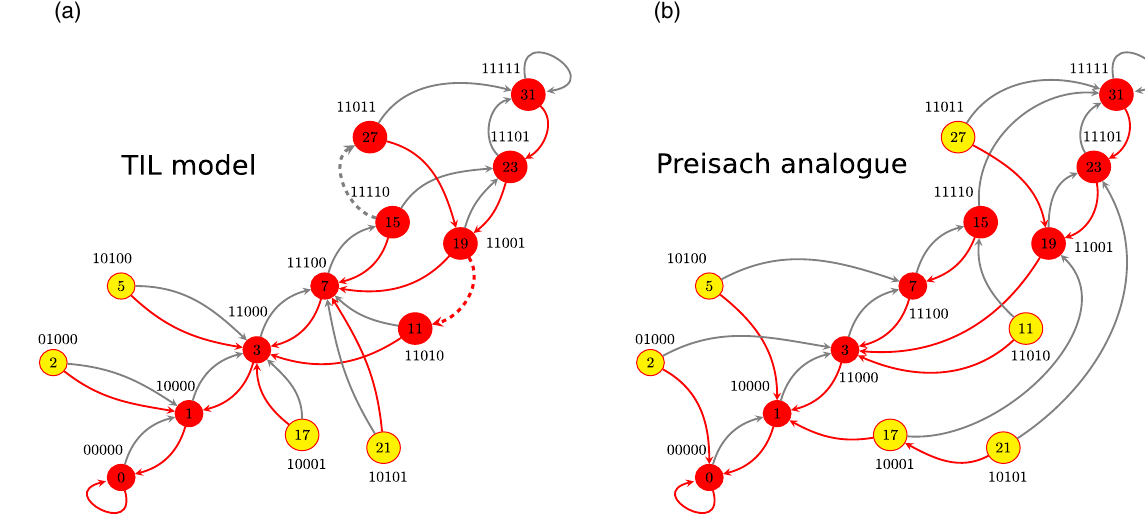
FIG. 3. Transition graph of a realization of the TIL model (a) and its Preisach analog (b) with L ¼ 5 sites. The symbolic ordering sequence of this realization is given in Eq. (5). Each genotype is assigned an integer label, placed within the nodes, by interpreting the genotype string as a binary code where the leftmost digit is the least significant. The gray arrows are U transitions and red arrows are D transitions. The yellow nodes are the genotypes that cannot be reached starting from the wild type. When multiple outgoing arrows are present from a state, the solid ones correspond to greedy walks, whereas the dashed lines represent fitness-increasing walks but with one or more steps that are not maximally fitness